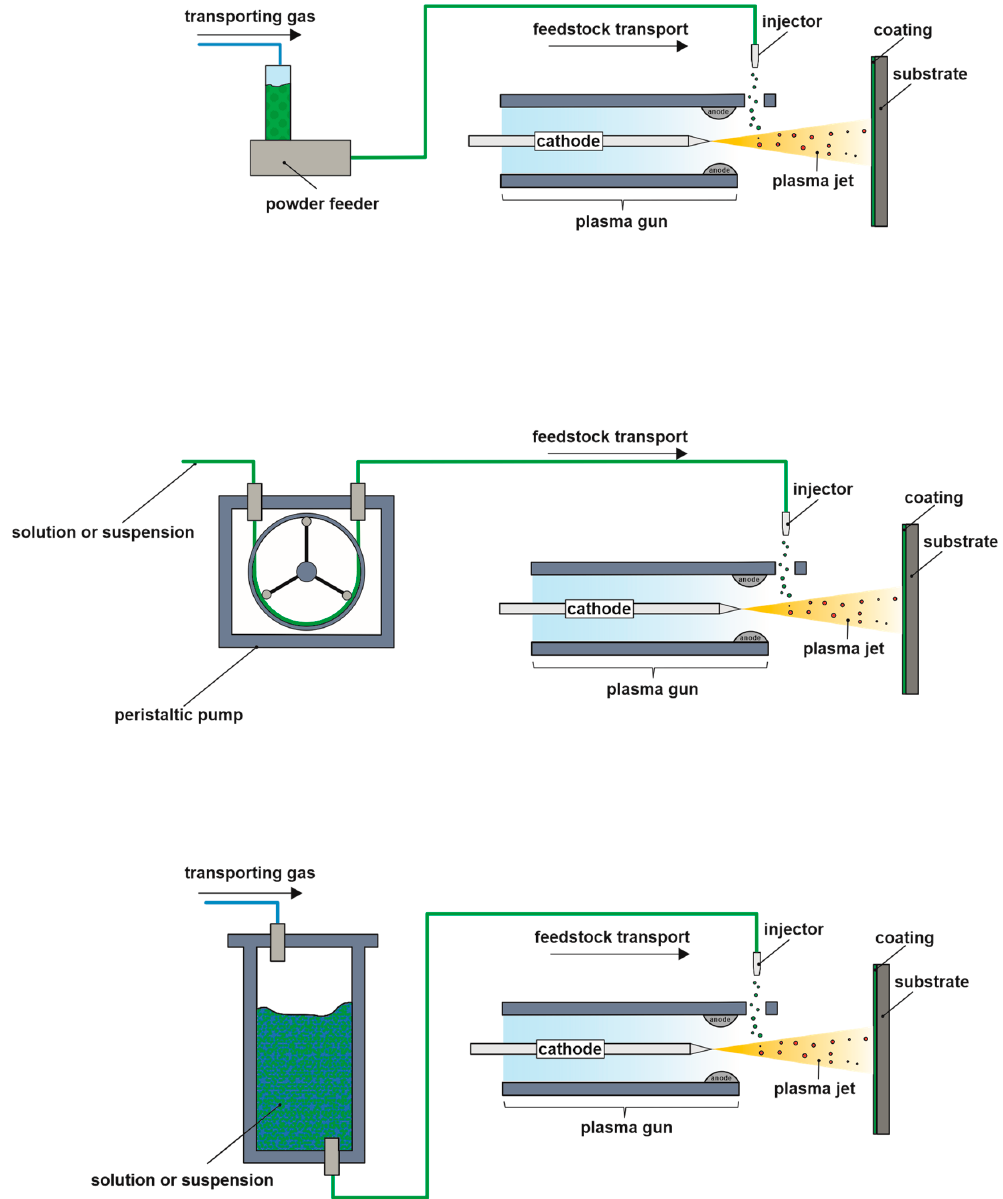
Figure 1. Schematic representation of the plasma spray deposition processes: atmospheric plasma spraying (APS) (up) and suspension plasma spraying (SPS) and solution precursor plasma spraying (SPPS)—(down) inspired by [8].